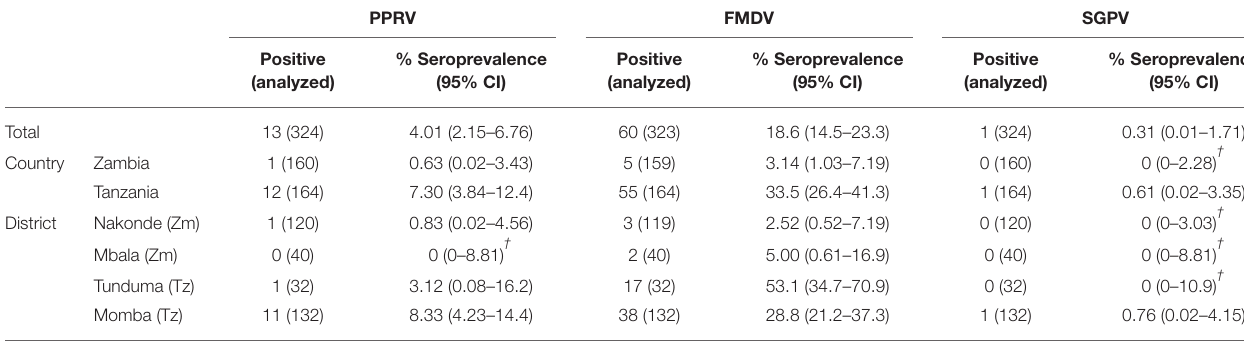
TABLE 5 | Apparent herd-level seroprevalence for PPRV, FMDV, and SGPV.